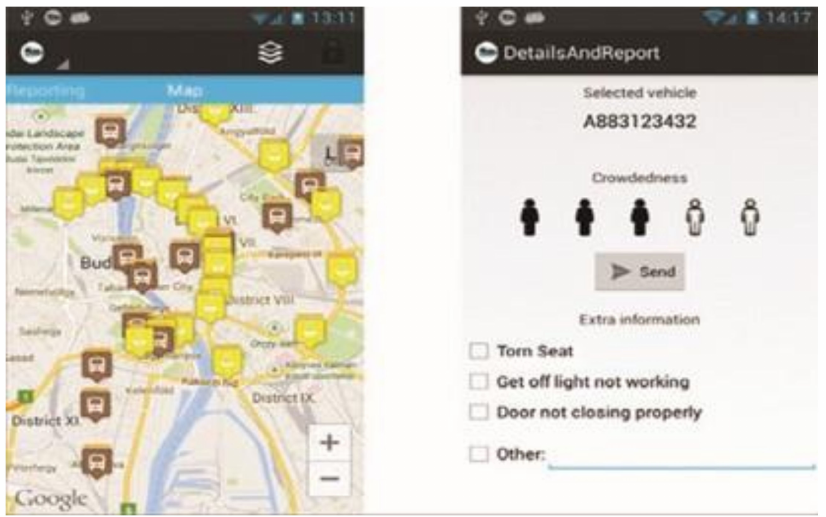
Figure 10. TrafficInfo smart transportation application